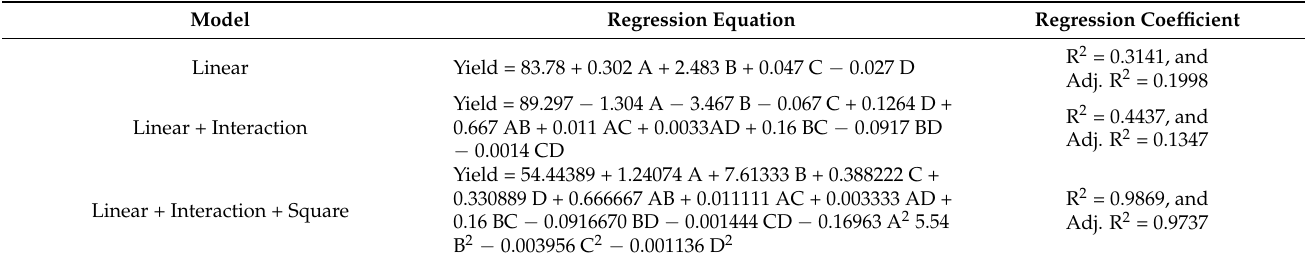
Table 4. Fitted models correspond to experimental input–output data.